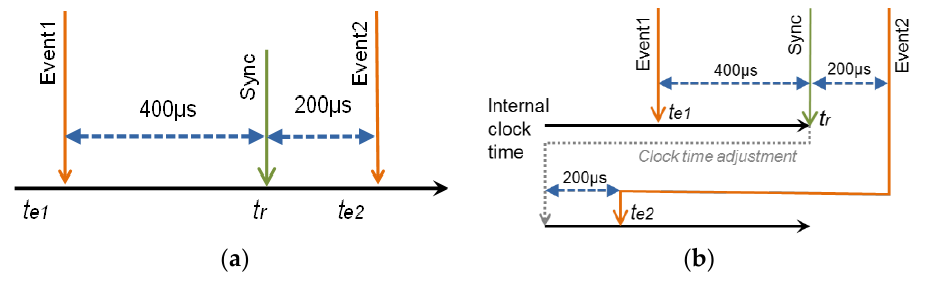
Figure 2. Almost simultaneous events and synchronization message, ( a ) with perfect clock (no) adjustment; ( b ) With erroneous internal clock (Set adjustment).